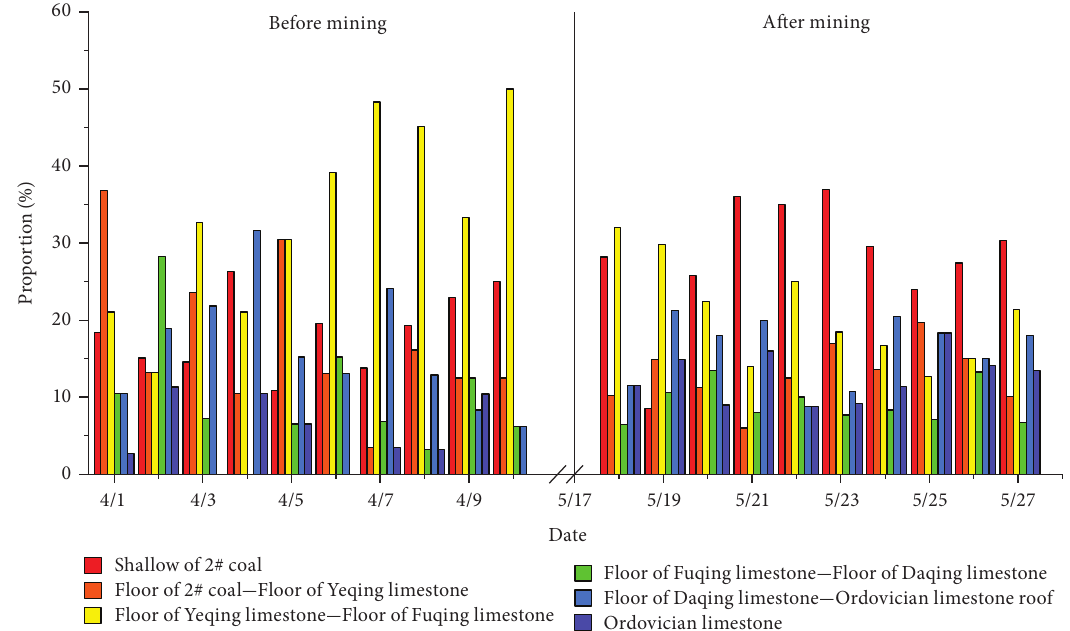
Figure 15: The proportion of microseismic events in each